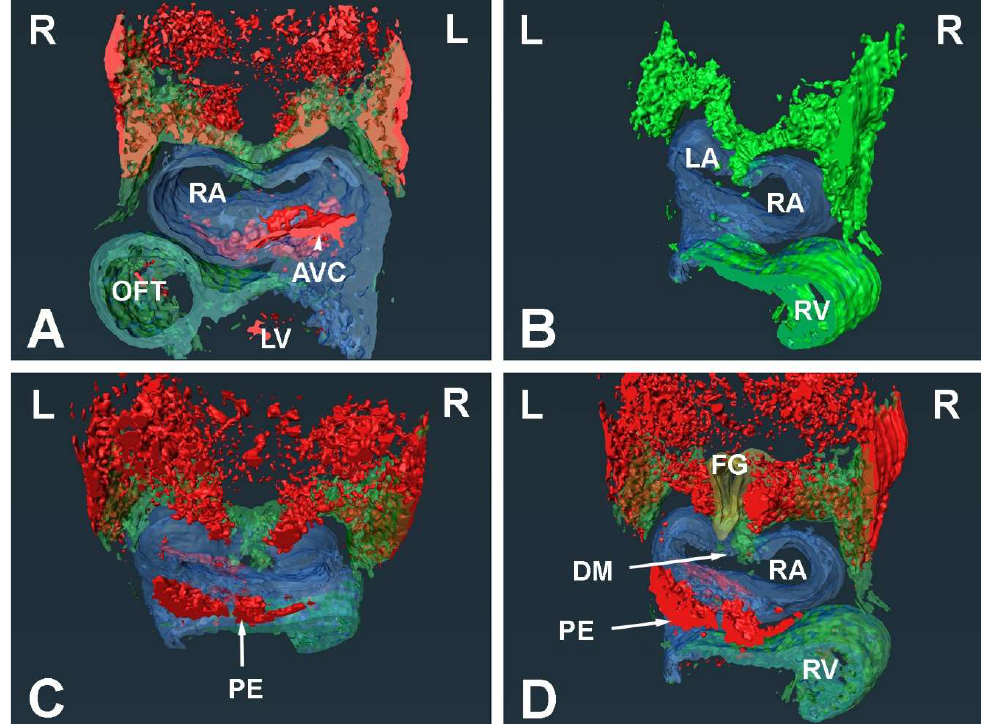
Figure 2. Three-dimensional reconstruction of the spatial distribution of Sox9 in the posterior SHF. Serial sections of an ED9.5 SHFcre;R26mG heart were immunofluorescently stained for Sox9 (red), Myosin Heavy Chain (blue), and GFP (green). In ( A – D ) the respective staining patters were 3-dimensionally reconstructed using AMIRA-3D software. AVC = atrioventricular cushion, DM = dorsal mesocardium, FG = foregut, PE = proepicardium, OFT = outflow tract, LA = left atrium, LV = left ventricle, RA = right atrium, RV = right ventricle.